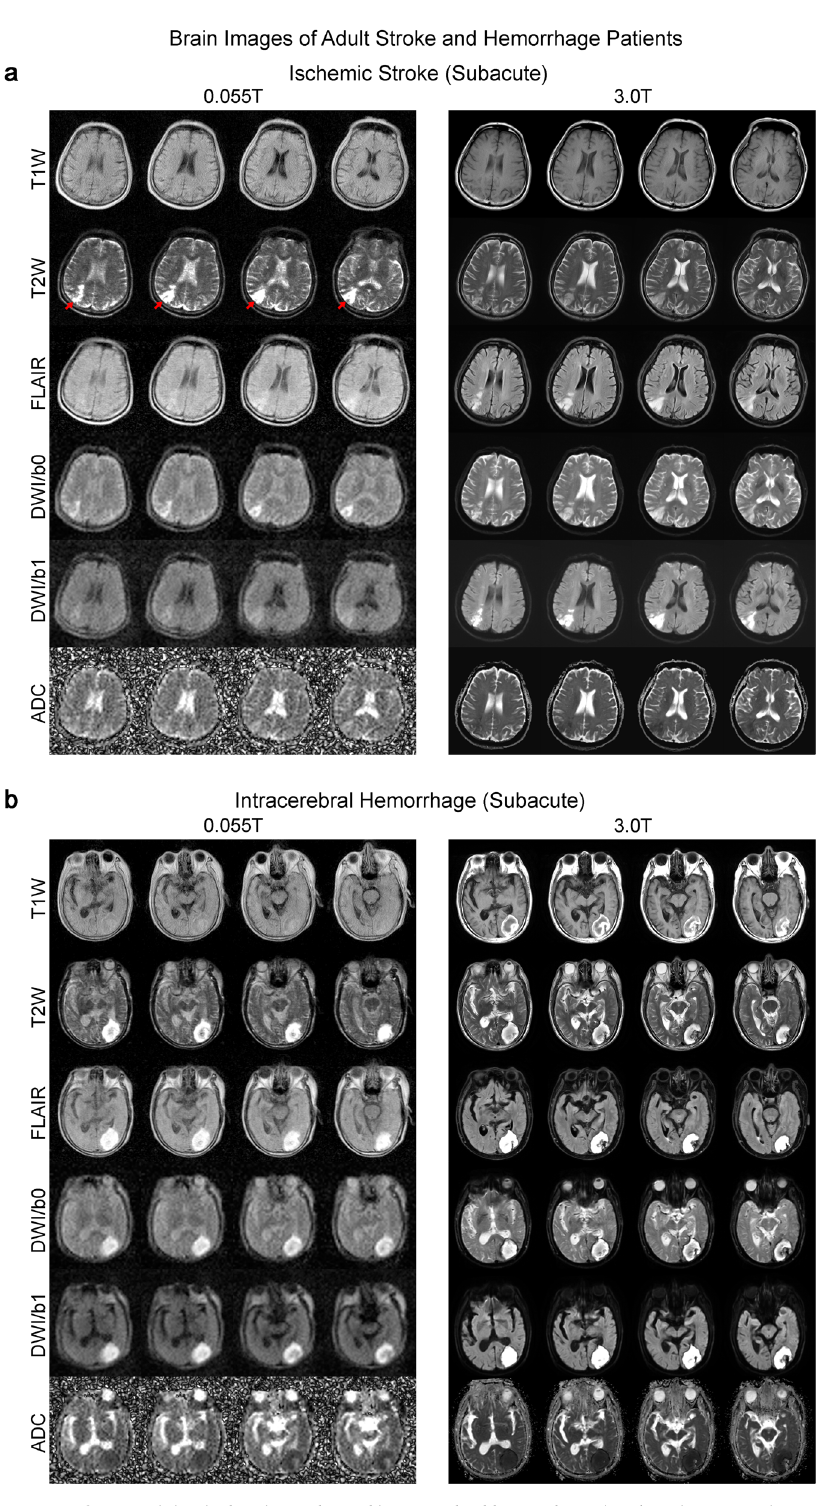
Fig. 7 Clinical utility of 0.055 T MRI for examining ischemic stroke and intracerebral hemorrhage (ICH) patients. Total 0.055 T scan time was ~30 mins for each patient. The patients were also scanned by a clinical 3 T MRI using the standard clinical protocols (~20 mins total scan time). a Subacute (~3 weeks) ischemic stroke patient (67 yrs. old; male). Note that 3 T clinical brain images were acquired 3 weeks prior to those acquired at 0.055 T. Ischemic infarct in the right parietal cortex (indicated by red arrows) was hyperintense in T2 and FLAIR images at 0.055 T and 3 T. Further, infarct was mildly hyperintense at ULF DWI, whereas it was hyperintense at 3 T. ADC showed slight hyperintensity at 0.055 T and hypointensity at 3 T. The corresponding signal changes for DWI and ADC maps at 0.055 T and 3 T are highly consistent with the expected progression of ischemic stroke across different timepoints (i.e., subacute vs. acute) 32 . b Subacute (~3 weeks) ICH patient (81 yrs. old; male). 0.055 T and 3 T images were acquired on the same day. Hematoma was visible in the left occipital lobe at 0.055 T and 3 T. It showed a hyperintense rim with a hypointense core in T2W images, indicating blood product and/or hemosiderin of different stages at the rim and core